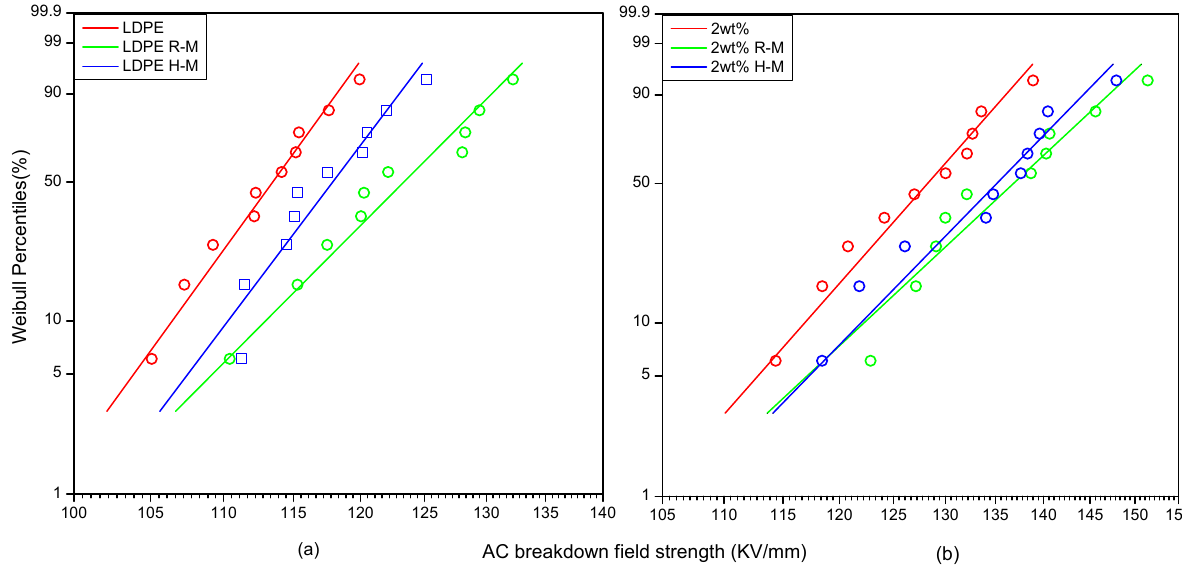
Figure 5. Weibull distribution of AC breakdown between the LDPE and composites under different magnetization condi- tions. ( a ) is the Weibull distribution of LDPE. ( b ) is the Weibull distribution of BiFeO 3 /LDPE composite. Curves LDPE and 2 wt% indicate no magnetization treatment. R-M is room temperature magnetization. H-M is high temperature magneti- zation.